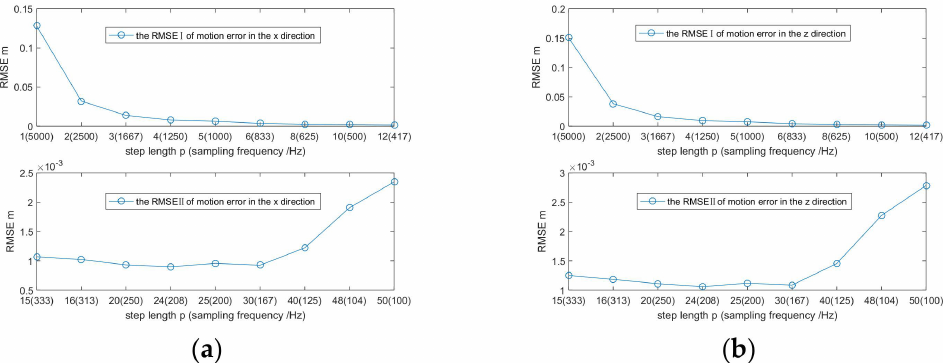
Figure 10. ( a ) Variation in the RMSEs with different step lengths in the x direction (simula- tion experiments); ( b ) Variation in the RMSEs with different step lengths in the z direction (simulation experiments).